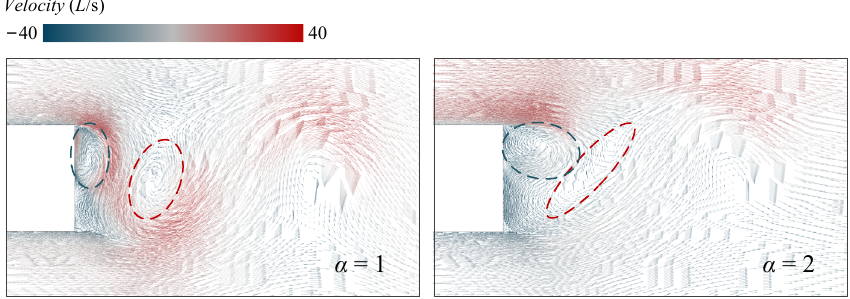
Figure 7. Velocity vectors downstream of the hydrofoil under different α.